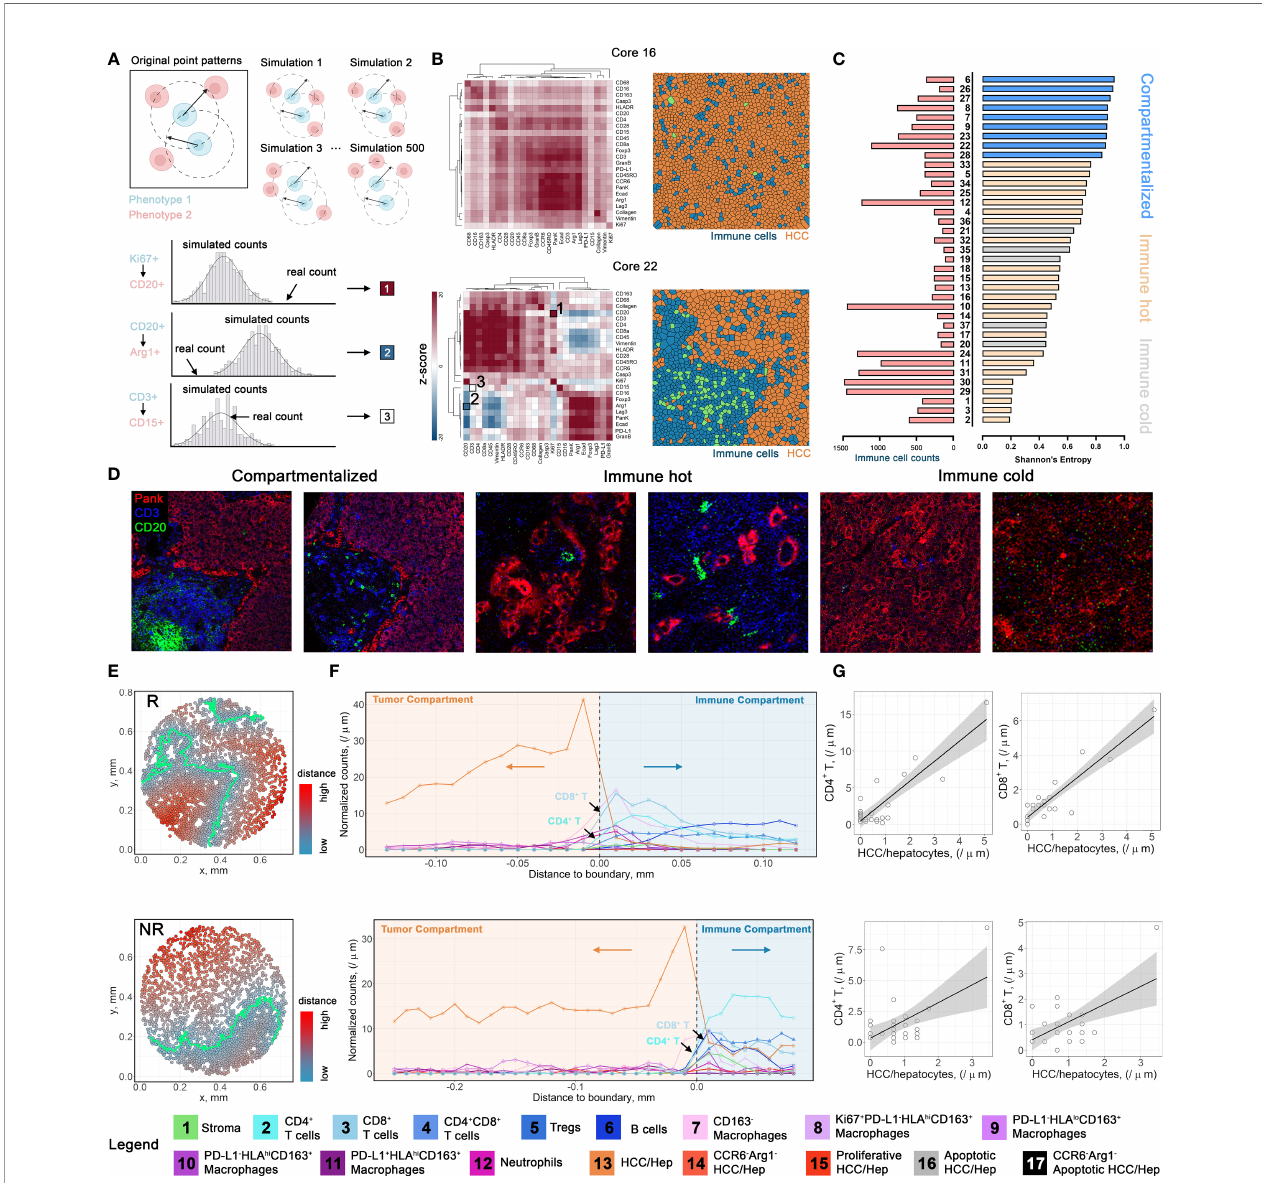
FIGURE 4 | Spatial architecture characterization and cellular in fi ltration pro fi ling. (A) Multicellular protein-protein interaction methodology diagram. (B) Positive z- score indicates spatial clustering (red); negative z-score indicates spatial separation (blue); ~0 z-score indicates no spatial correlations (white). (C) Corresponding cores from the fi rst quartile of Shannon ’ s entropy were de fi ned as compartmentalized cores. Remaining cores with immune cell count > 200 were de fi ned as immune hot , otherwise as immune cold . (D) Image snippets for different tissue structure types. (E). Point patterns describing the relative distances to HCC/hepatocytes- immune boundaries for core 22 (upper) and core 8 (lower). Cells are color-coded by their distances to HCC/hepatocytes-immune border. (F). In fi ltration pro fi les of each cell type from cores highlighted in (E) . (G) Exemplar correlations between normalized cell counts of different cell types. Correlations were performed using Pearson ’ s method with FDR-adjustment for